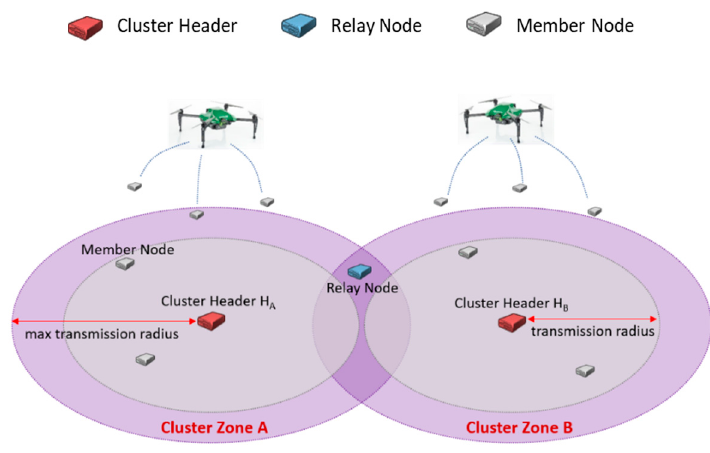
Figure 1. The terms for IoT hopping sensor networks.